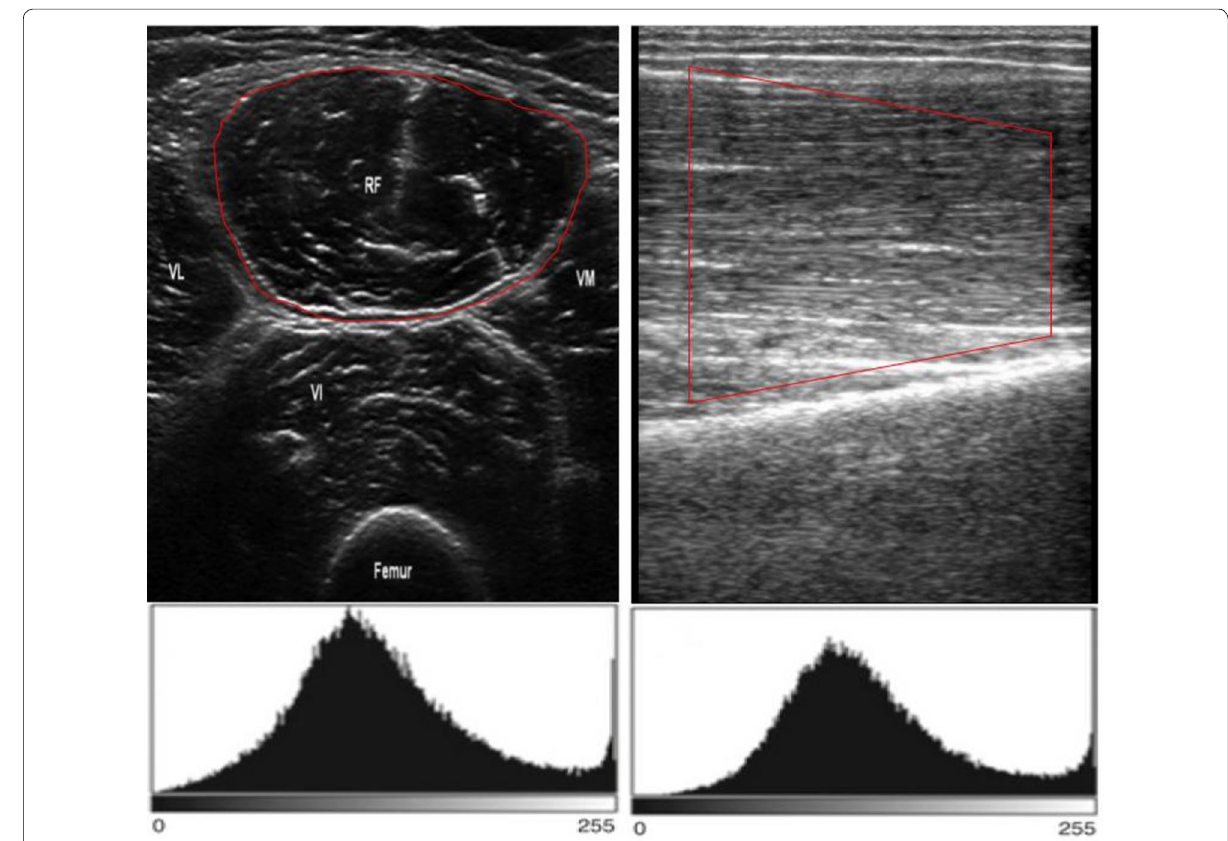
Fig. 4 The muscle ultrasound echointensity. An example of the grayscale histogram in the transverse (right) and longitudinal (left) axis of the rectus femoris